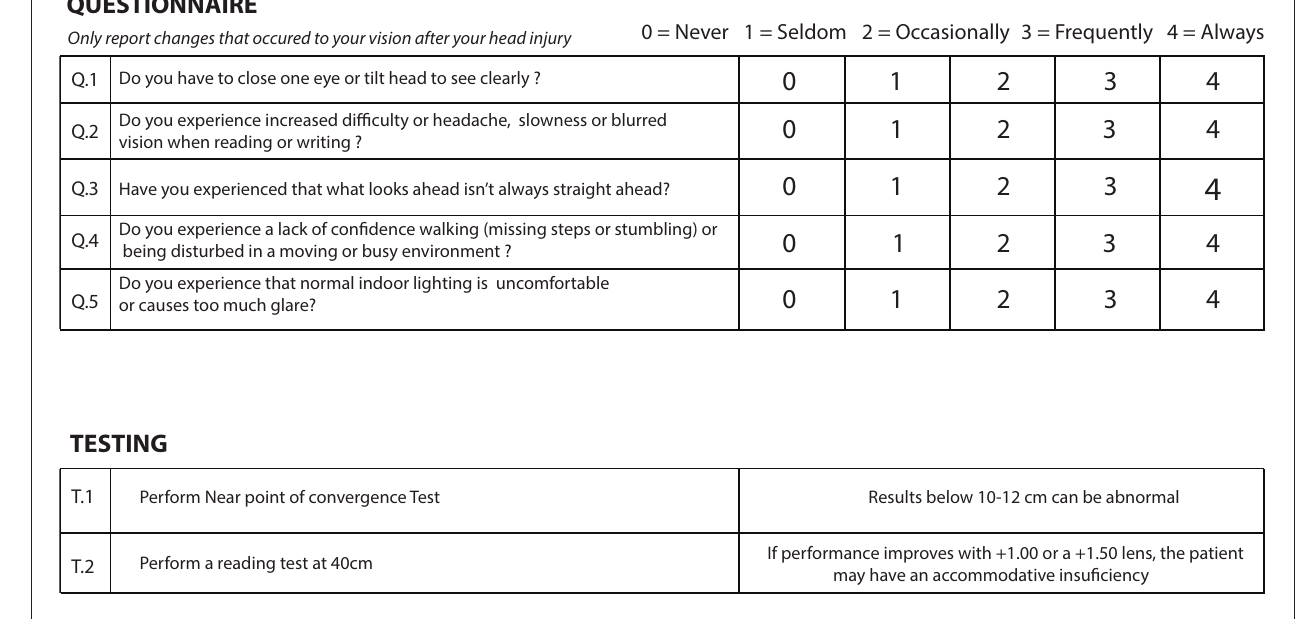
FIGURE 2 | Proposed visual screening